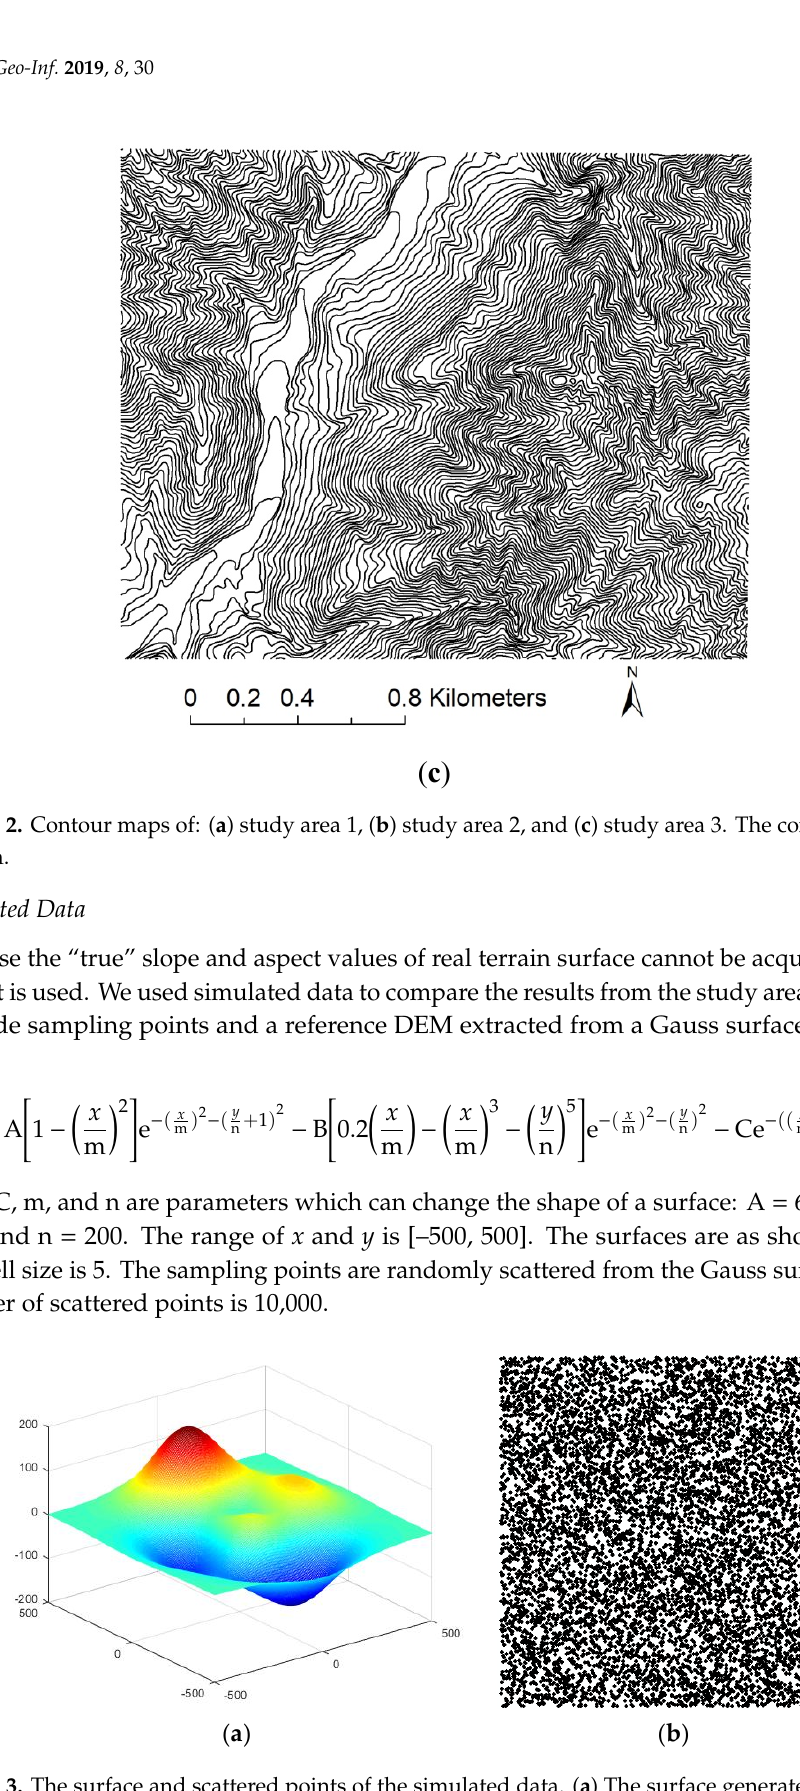
Figure 3. The surface and scattered points of the simulated data. ( a ) The surface generated by formula (1) and ( b ) points randomly scattered from the